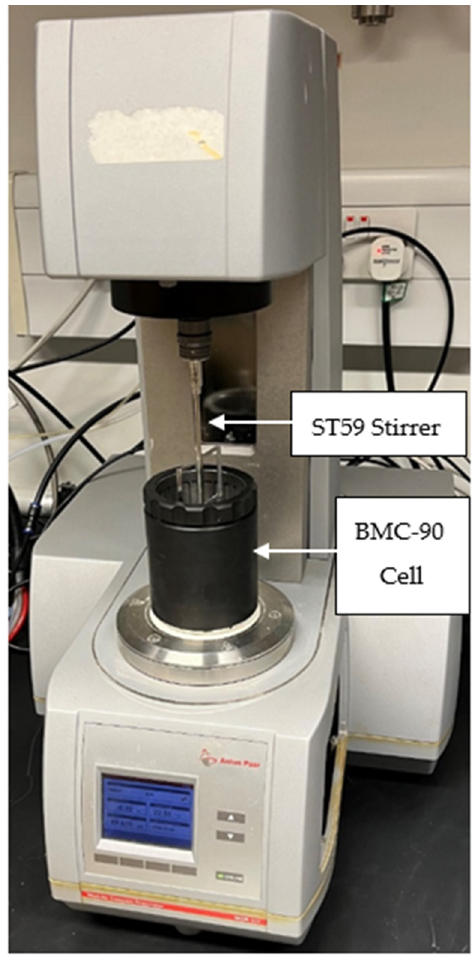
Figure 2. Anton Paar MCR 302 rheometer with the ST59 stirrer attachment and the BMC-90 cell.